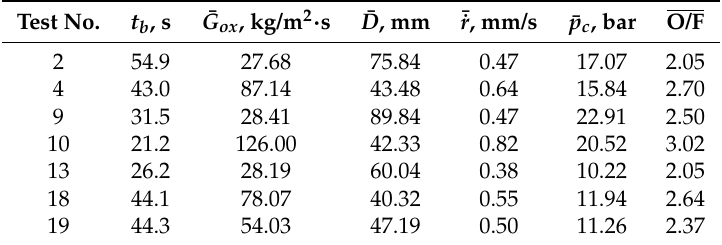
Table 4. Firing test average experimental results (HDPE)